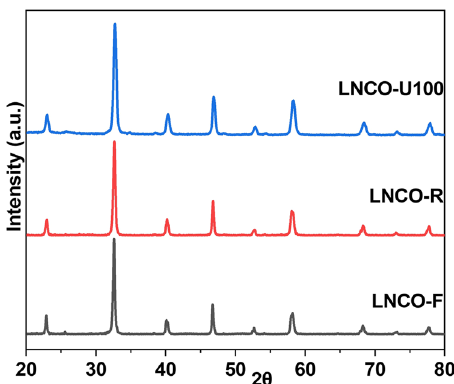
Fig. 2 XRD patterns of perovskite LNCO samples. The XRD patterns are normalized. LNCO-F, LNCO-R, and LNCO-U100 represent fresh, H 2 - reduced, and used after 100 h time on stream LaNi 0.05 Co 0.05 Cr 0.9 O 3 samples, respectively.